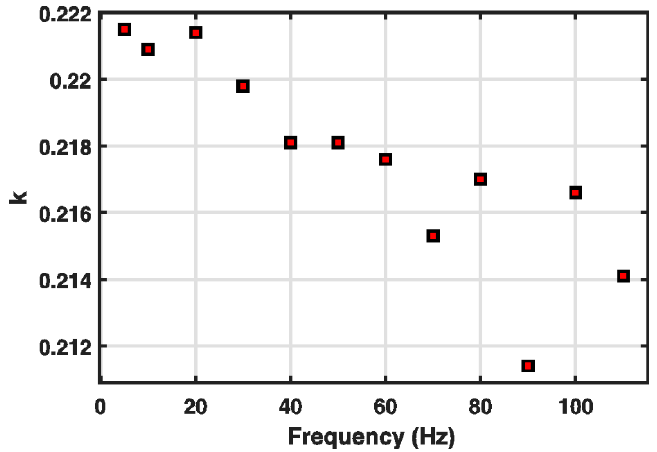
Figure 1. Variations of k under u ( t ) = 5sin ( 2 π ft ) + 5 at different frequencies.